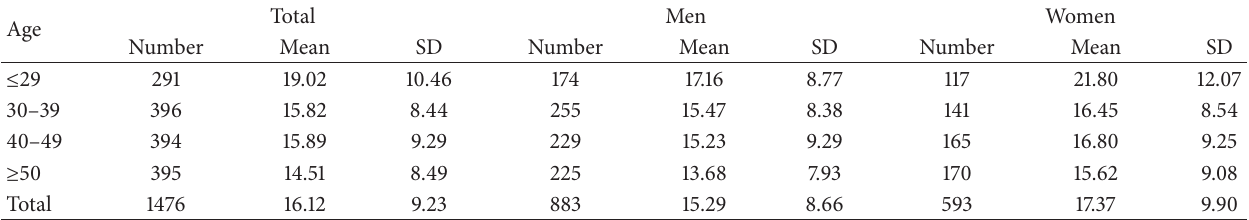
Table 1: Numbers, mean scores, and standard deviations of the CES-D scores according to sex and age in the 2010